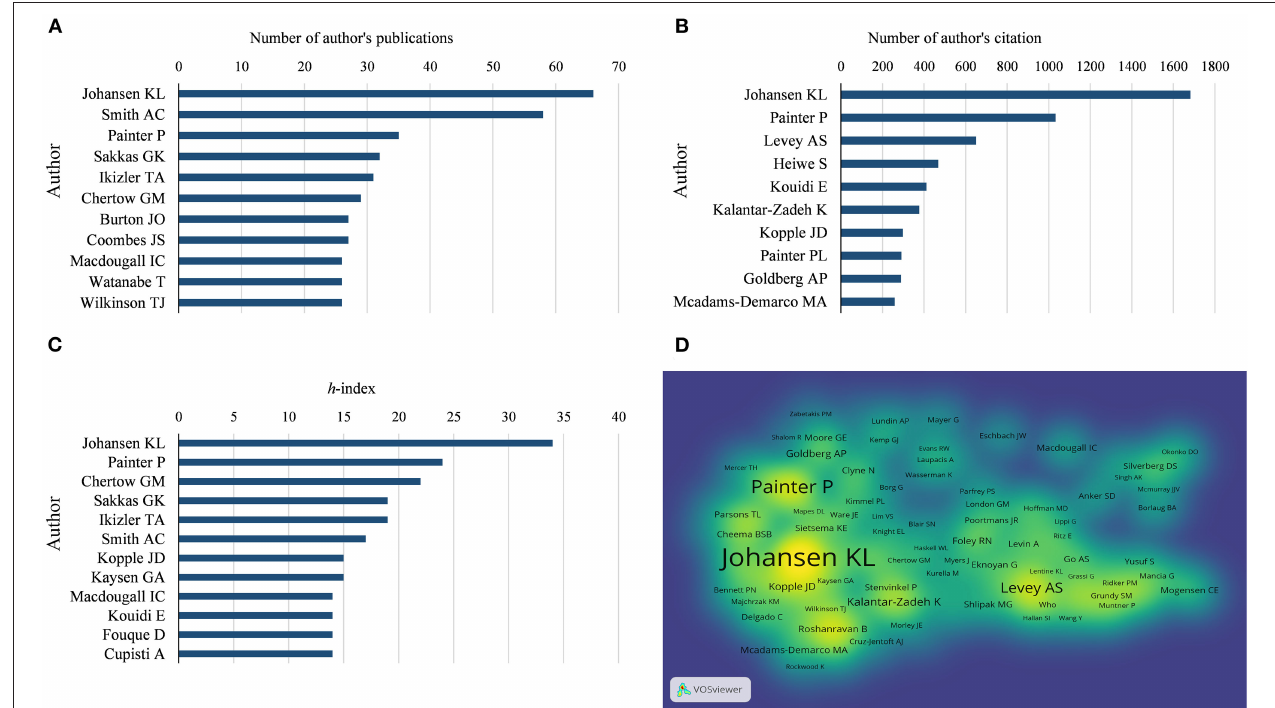
FIGURE 5 | Analysis of authors. (A) The number of author’s publications. (B) The number of author’s citations. (C) Authors’ overall h -index. (D) Density visualization of co-citation of authors. The h -index is a common metric for measuring the impact of researchers, which measures the number of articles with at least h citations per article by the author (21).